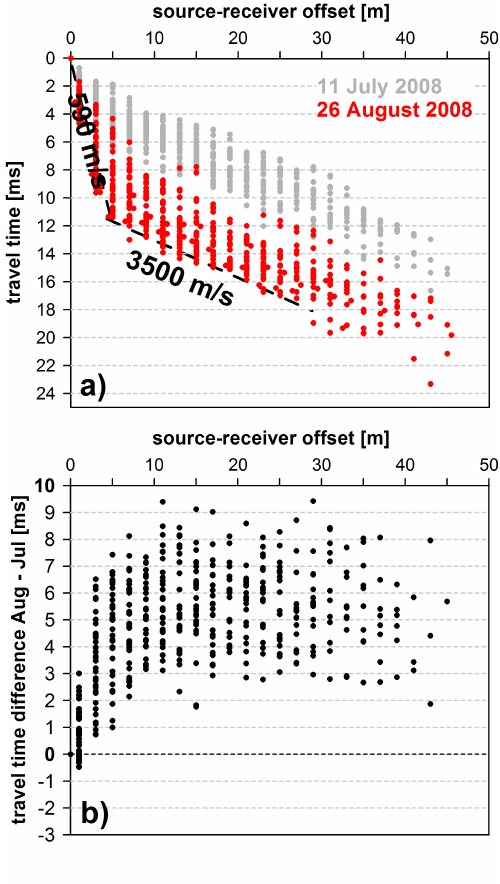
Fig. 7. Common offset plot of (a) the travel times and (b) the travel time differences at Schilthorn for 11 July 2008 and 26 August